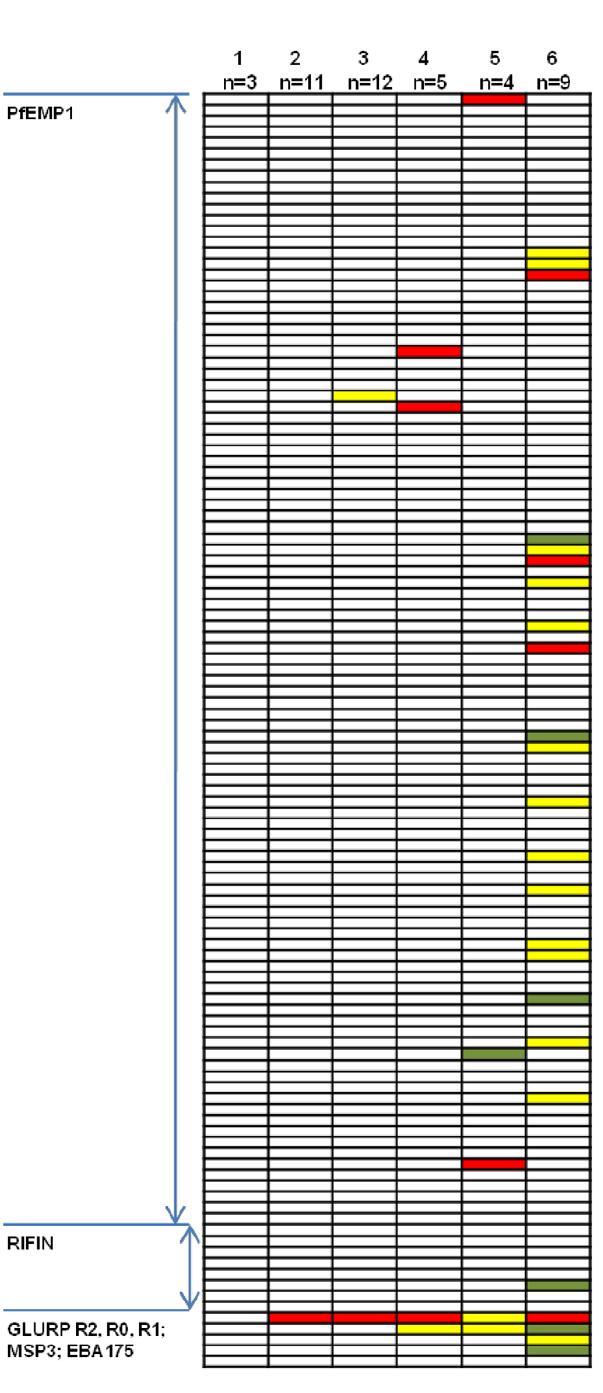
Figure 3. Acquisition of IgG to 104 PfEMP1 domains, eight RIFINs, and GLURP, MSP3, and EBA-175 antigens of Plasmodium falciparum in malaria naı¨ve individuals exposed to controlled experimental P.falciparum infections. The IgG reactivity pattern of the six groups represented by their acquisition pattern of IgG to blood stage antigens observed in the 44 examined volunteers after exposure of a short P. falciparum infection: Volunteers with no acquisition of antibodies to any of the tested malaria antigens ( n =3); volunteers who acquired antibodies to GLURP only ( n =11); and volunteers who acquired antibodies to 1, 2, 3 or . 3 PfEMP1 domains, respectively, as well as one or more merozoite antigens ( n= 12, 5, 4 and 9). Results are expressed as median fluorescent intensity (MFI): Red . 2000 MFI; Green . 1000 MFI; Yellow . 500 MFI (cut-off value).